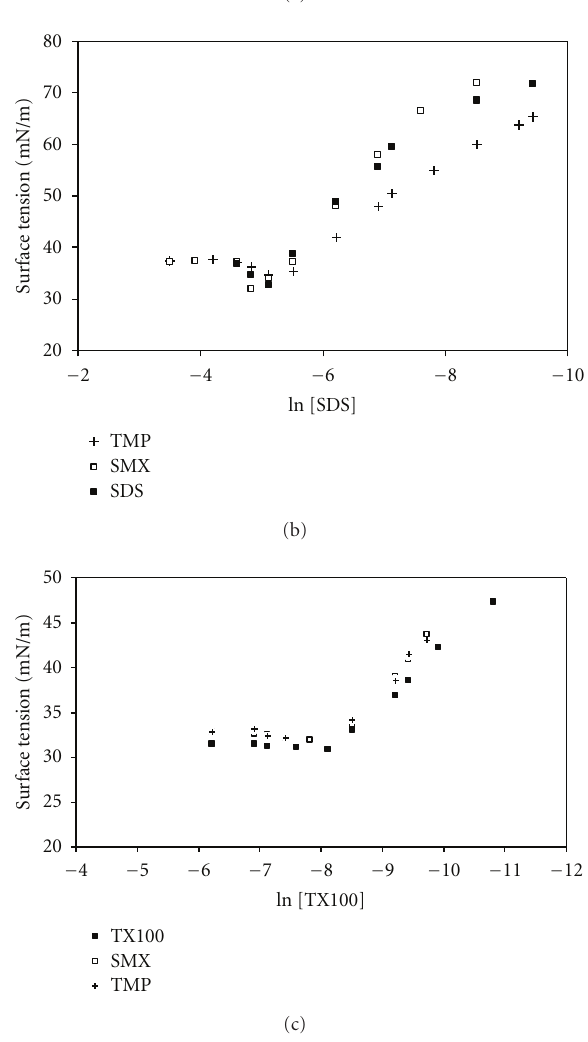
Figure 6: (a) Surface tension results for SDS and CDs in the presence of 4 . 0 × 10 − 5 M TMP at 298 K. (b) Surface tension versus ln (concentration) plots for SDS in the absence ( (cid:2) ) and presence of 4 . 0 × 10 − 5 M SMX ( (cid:3) ) and TMP(+) at 298 K. (c) Surface tension versus ln (concentration) plots for TX100 in the absence ( (cid:2) ) and presence of 4 . 0 × 10 − 5 M SMX ( (cid:3) ) and TMP(+) at 298K.